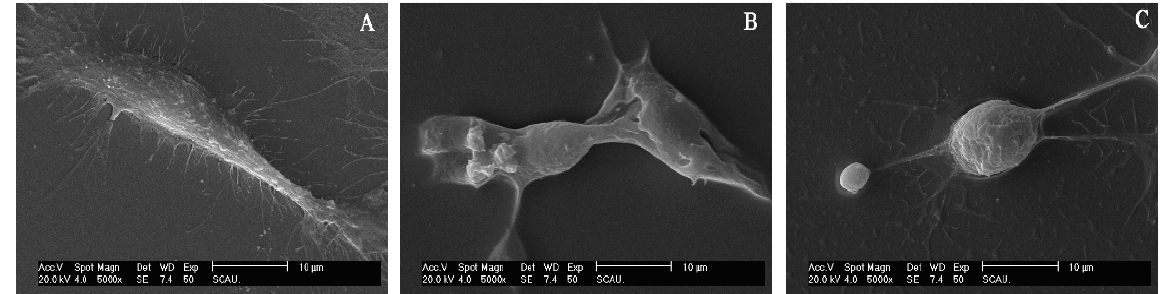
Figure 5. Morphological differences in SL-1 cells after 24 h treatment with different concentrations of rotenone. Control: ( A ); 0.2 µg/mL of rotenone: ( B ); 20 µg/mL of rotenone: ( C ).